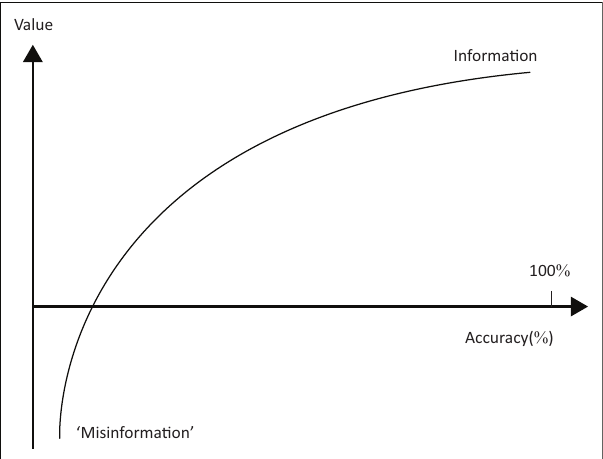
FIG URE 2: Value increases with